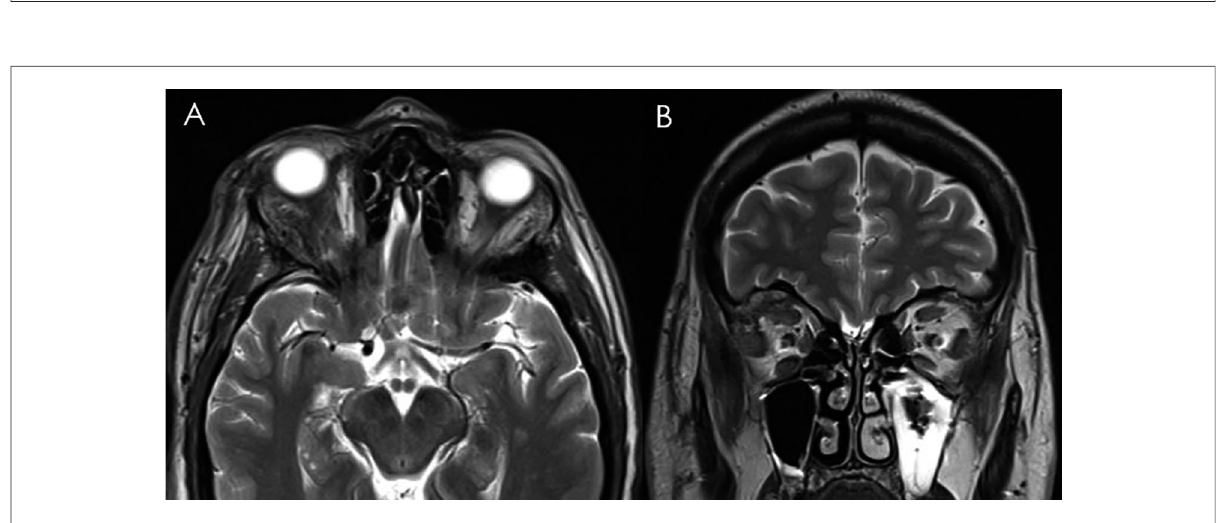
FIGURE 3 Intraoperative images. An endoscopic transorbital superior eyelid approach was performed. Sharp ( A ) and smooth ( B,C ) dissection of the CVM from the periorbita, until entire exposure of the lesion is achieved ( D ). Gentle coagulation of the capsule with bipolar forceps ( E ). En bloc resection of the CVM ( F